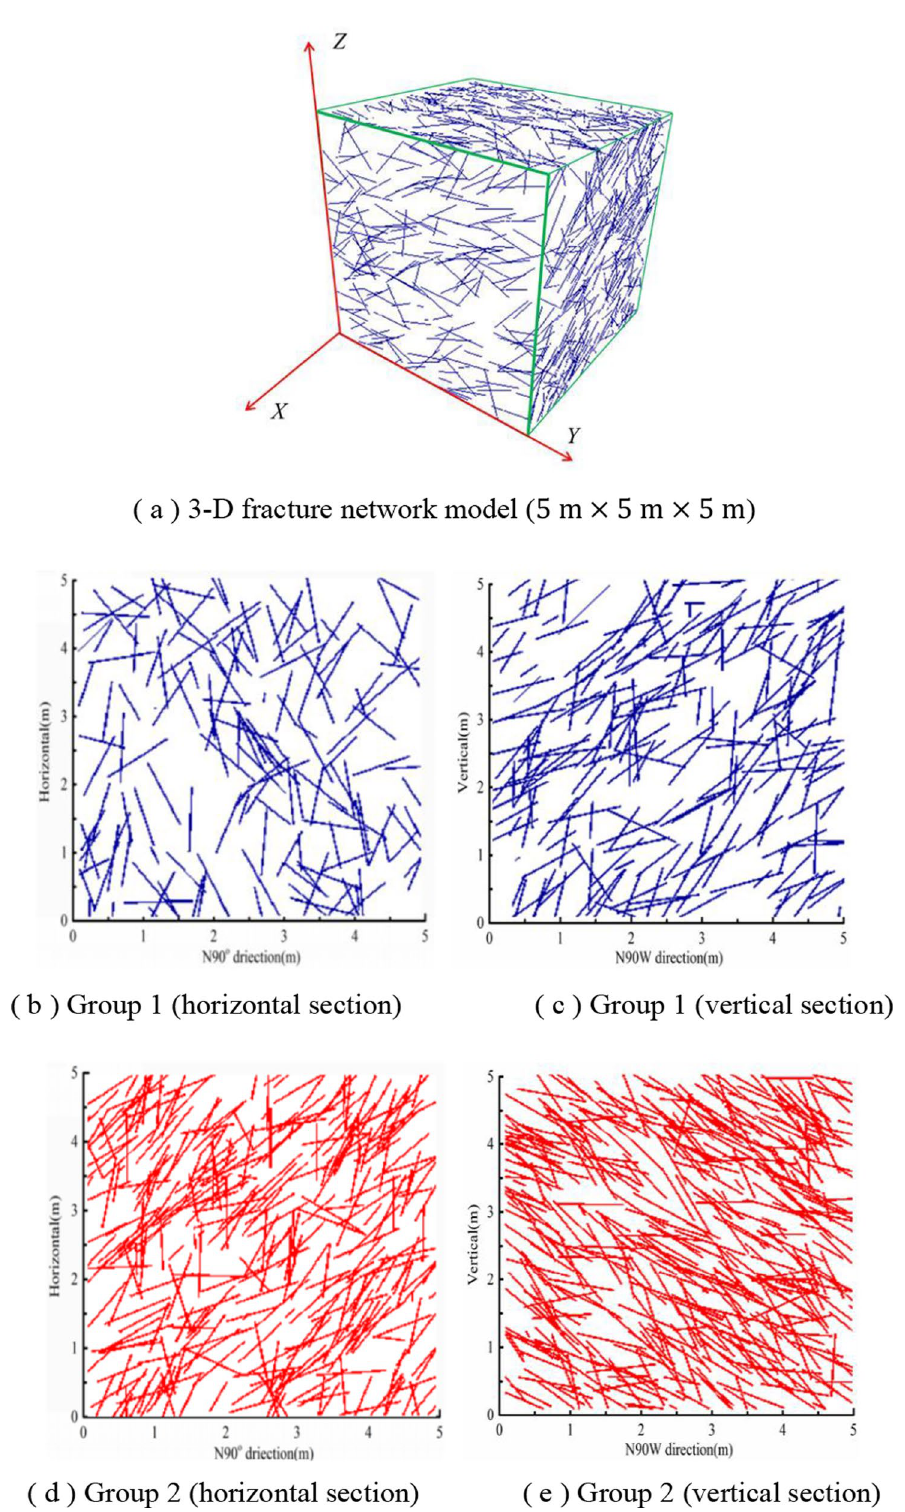
Fig. 3 A 3-D fracture network model and profiles of the outcrop of the Carboniferous Hurleg Formation shale in the eastern Qaidam